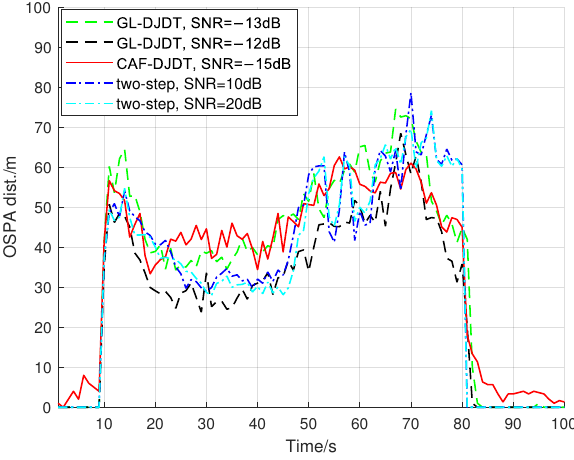
Figure 6. OSPAs of considered methods with different SNRs.